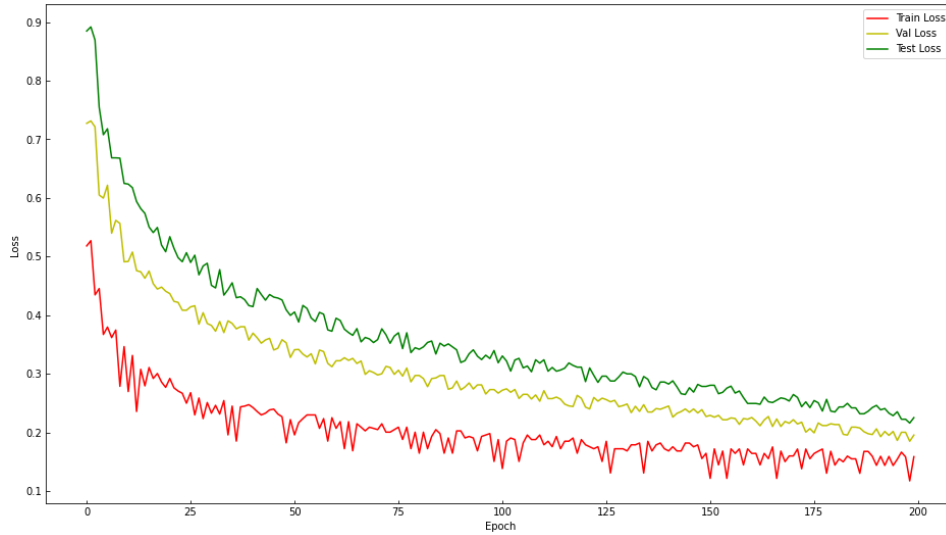
Figure 7. Training loss